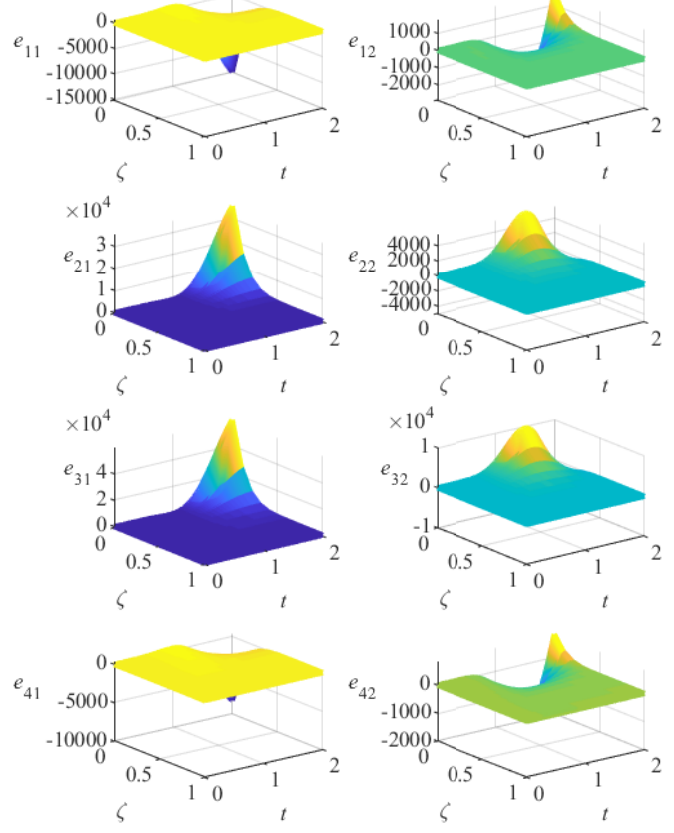
Figure 4. e ( ζ , t ) of HPDECSTN (1) without